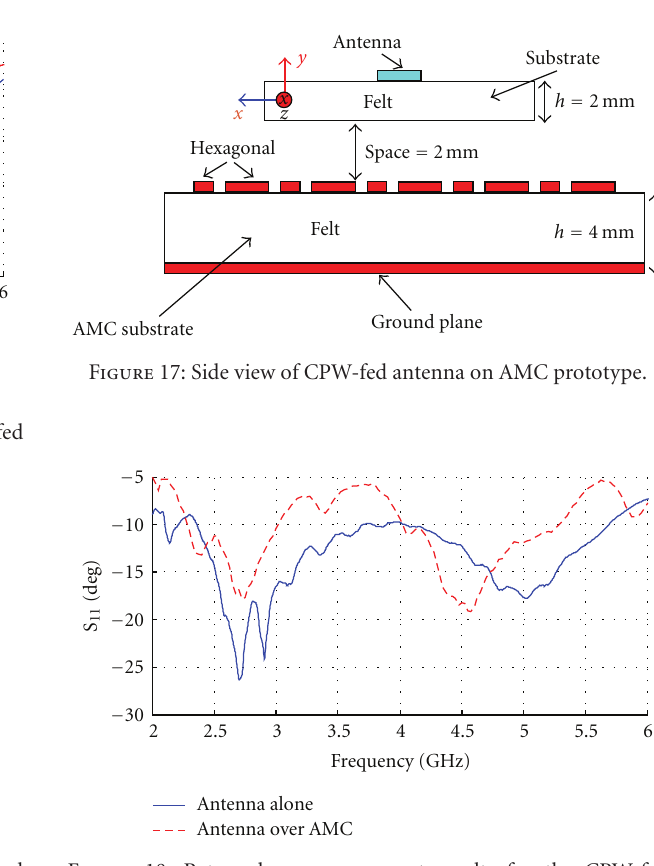
Figure 18: Return loss measurement results for the CPW-fed antenna alone and for the CPW-fed antenna on